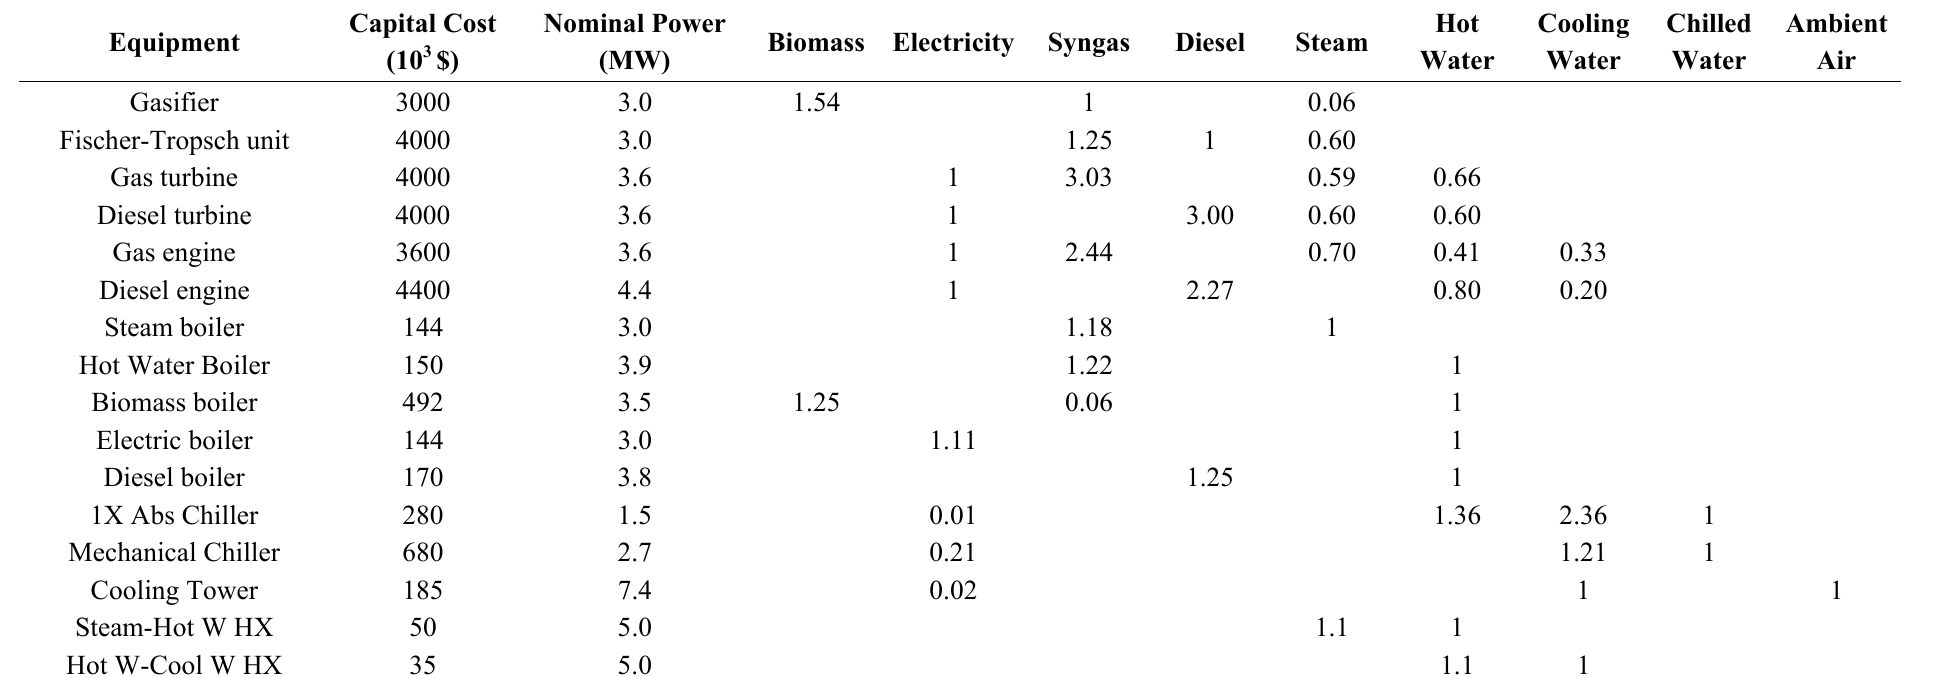
Table 1. Selected equipment and matrix of production